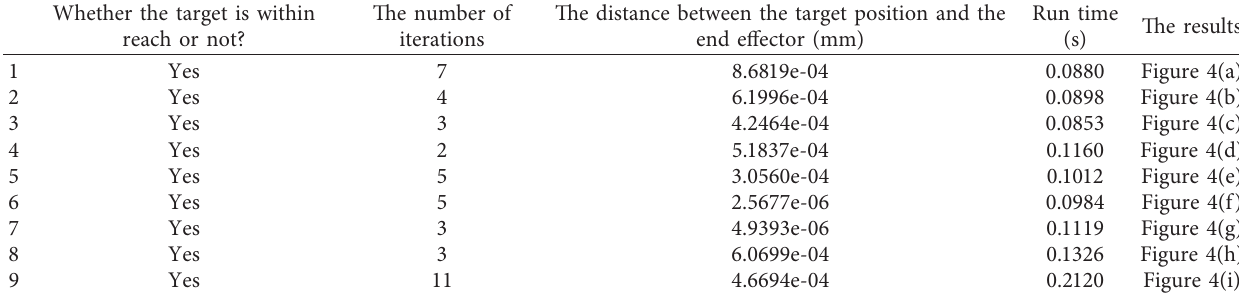
Table 2: The experiment results of extending FABRIK with obstacle avoidance in test 2. Whether the target is within